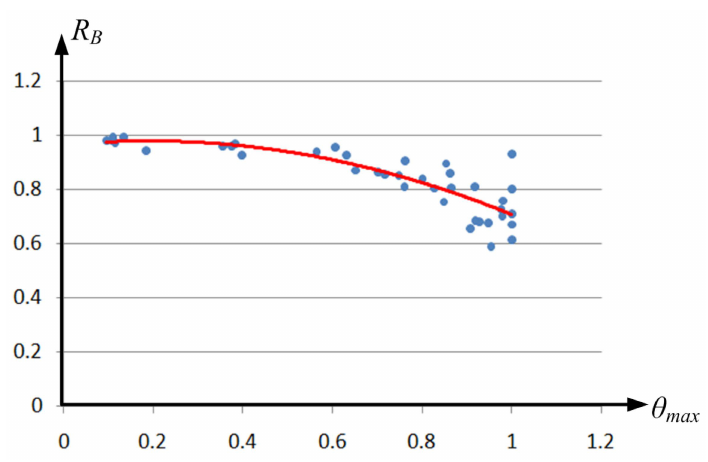
Figure 4. Regression curve and points for R B vs. θ max for the data in Table 1.